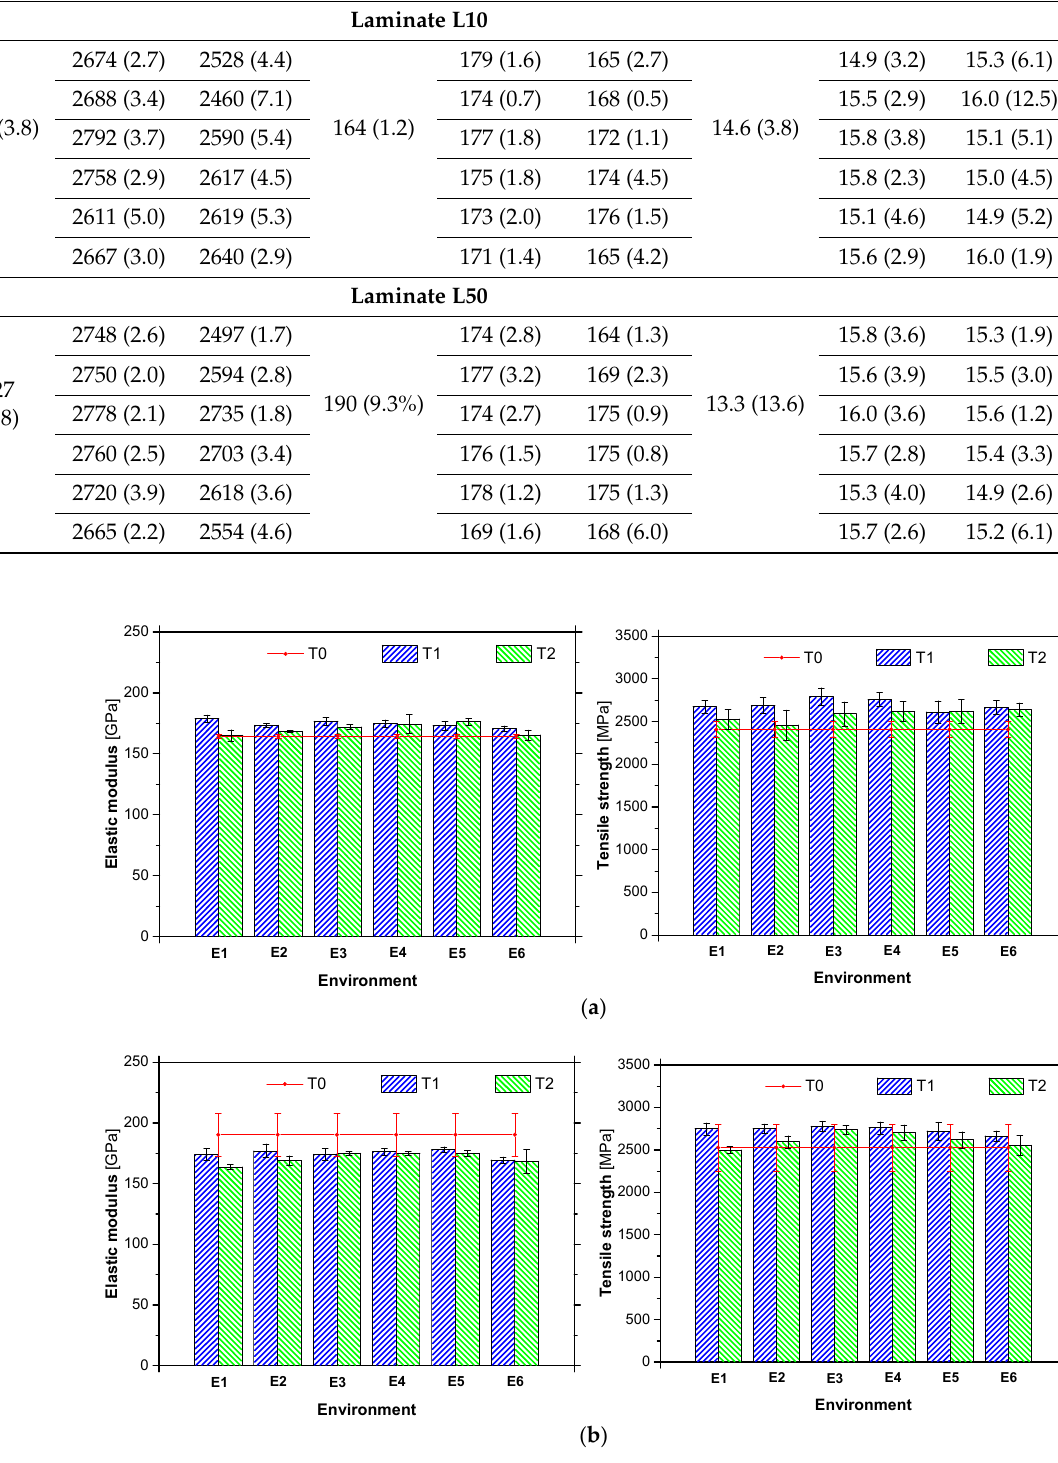
Figure 13. ( a ) Elastic modulus and tensile strength of ( a ) L10 and ( b ) L50 laminates, after one (T1) and two (T2) years of exposure to the environment studied (E1 to E6), including the reference (T0). The values obtained for f fu and E f at the time T0 are in agreement with the ones claimed by the supplier. Regardless of the exposure period, in general the type of envi- ronment had a minor influence on the mechanical performance of the CFRP laminates (for the same period of exposure, the difference between the maximum and minimum value observed in the different environments is equal to 6.0%). However, when the period of exposure is considered, a tendency of decreasing mechanical properties with the increase of exposure time is observed (an average value of 3.6% was obtained)—a maximum vari- ation of 9.3% was found for the environment E2 between T1 and T2. This variation (from T1 to T2) seems to be higher in the case of strength than in the case of elastic modulus. When T0 is considered in the analysis, in general, for T1 and T2 higher values of the me- chanical properties are observed, probably due to a post-curing phase. Finally, regardless the type of environment, the CFRP laminates have presented a low reduction of their me- chanical properties. 4. Accelerated Ageing versus Natural Ageing In order to compare the accelerated ageing tests with natural ageing, two databases of accelerated ageing tests (one for epoxy adhesives and another for CFRP laminates) were developed by collecting data from the literature. Then, this data was compared with the results obtained from specimens under natural ageing, developed in the present work. The database of results of accelerated ageing tests of epoxy adhesive presents the following characteristics: